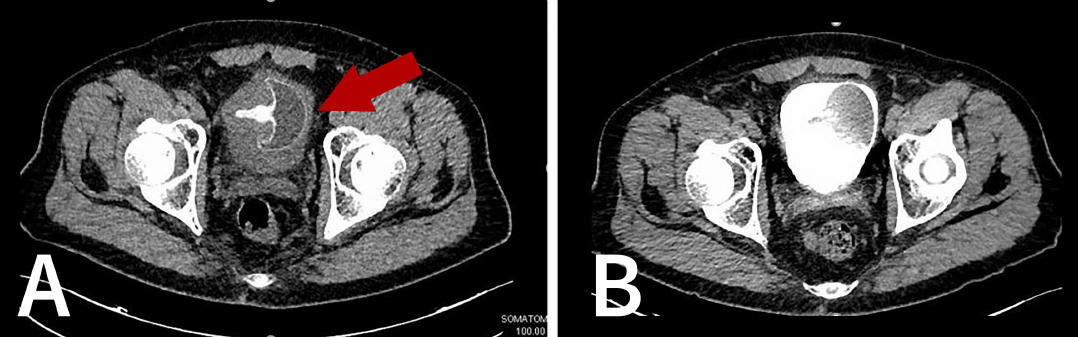
Fig. 2. A computed tomography scan abdominal-pelvic protocol. (A) Without contrast, the arrow pointing at the reservoir. (B) With contrast, no extravasation was